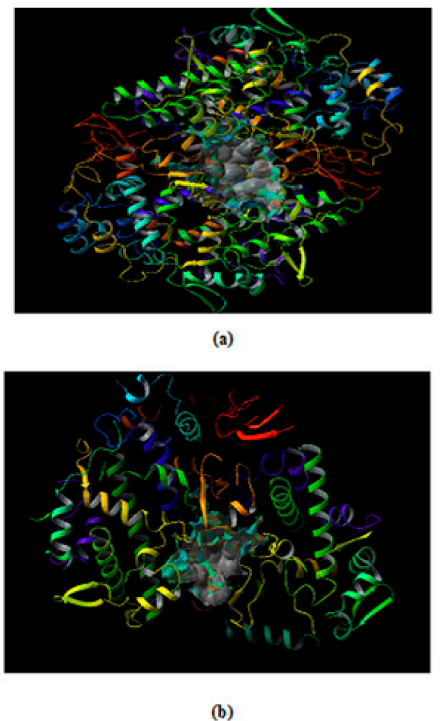
Figure 4. Predicted binding site in COX-2 (target protein) from ( a ) mouse (PDB ID 3NT1) ( b ) human (PDB ID: